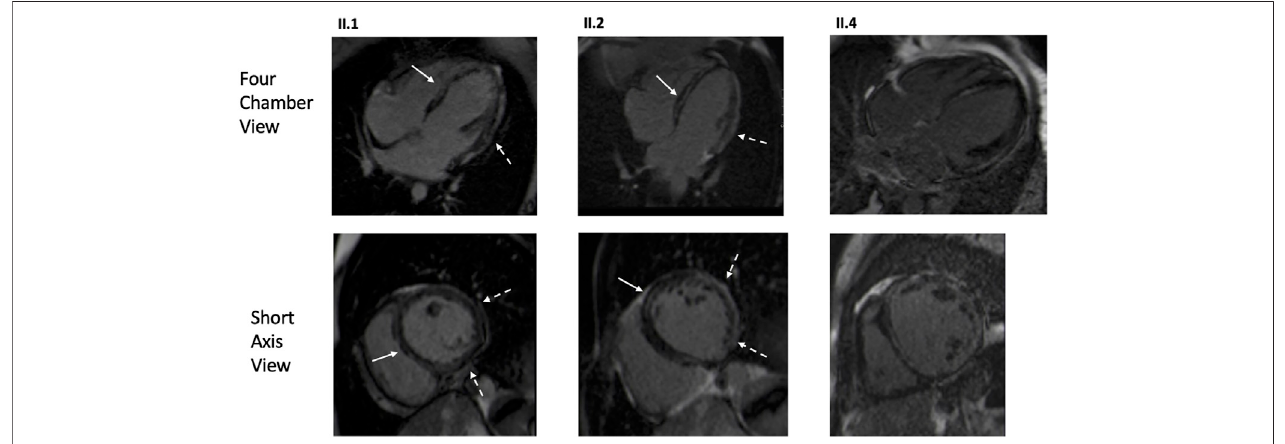
FIGURE3| CMRimagesoftheproband (Family1,II.1),affectedfamily member withhomozygous GCOM1 p.(Arg130*) (Family1,II.2), andaffectedfamilymember withnofamilial mutationbut DCM secondary tolymphocyticmyocarditis(Family1, II.4).Bothhomozygotes(II.1, II.2) presented mid-wallLGEinthe septum (arrows)and subepicardial enhancement in the inferolateral areas (dashed arrow). The genotype negative patient (II.4) exhibited multifocal and patchy LGE involving several layers of the